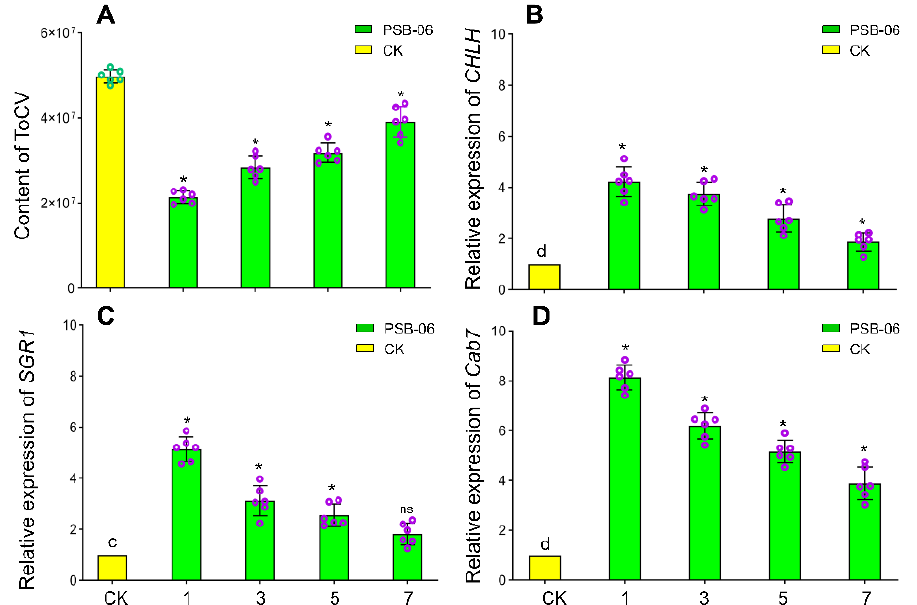
Figure 1. Gene expression in tomato plants after spraying PSB-06 at different times. ToCV accu- mulation in tomato plants ( A ). The relative expression of CHLH in the pathways of chlorophyll development ( B ). The relative expression of SGR1 in the chlorophyll metabolic pathway ( C ). The relative expression of Cab7 in photosynthesis ( D ). The X-axis indicates the different situations that the tomato plants were treated. CK: The tomato plants treated with water. 1: The tomato plants treated with PSB-06 daily. 3: The tomato plants treated PSB-06 every 3 days. 5: The tomato plants treated PSB-06 every 5 days. 7: The tomato plants treated PSB-06 every 7 days. Data are the means ± SE. Different letters on the bars indicate the significant difference ( p < 0.05). * p < 0.05; ns, not significant. SE, standard error; ToCV, Tomato chlorosis virus.